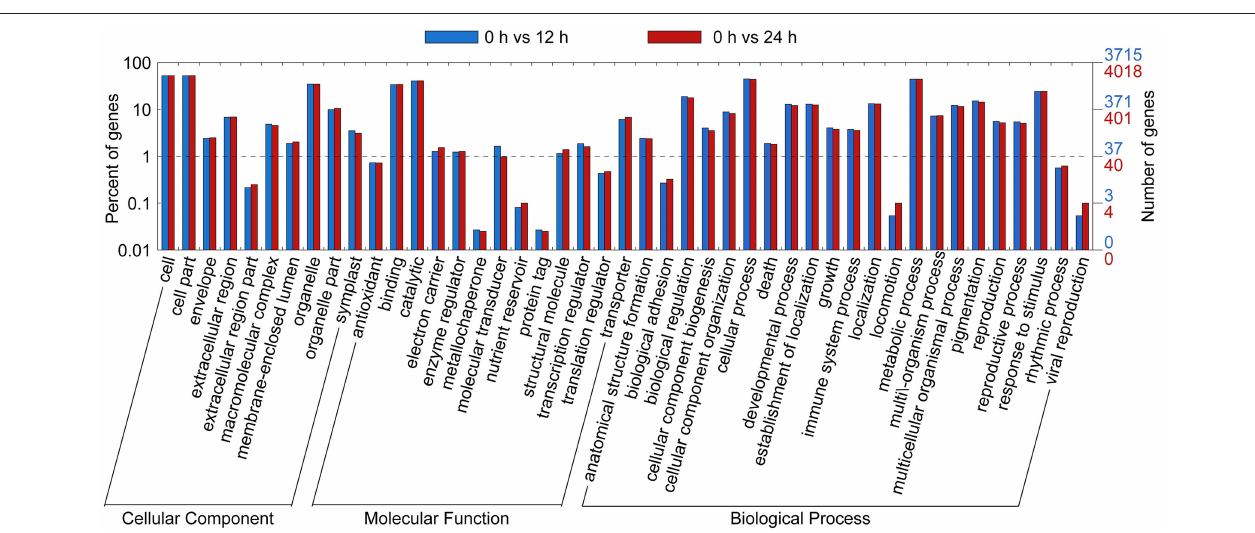
FIGURE 3 | Gene Ontology (GO) functional classification analysis of DETs based on RNA-Seq data. GO functional classification analysis of DETs in 0 vs. 12 h and 0 vs. 24 h. Based on sequence homology, 2,573 differentially expressed genes could be categorized into three main categories (biological process, cellular component, and molecular function), which include 25, 13, and 12 functional groups,